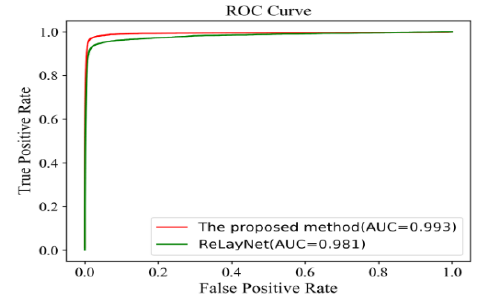
Figure 9. Comparison of receiver operating characteristic (ROC) curves.